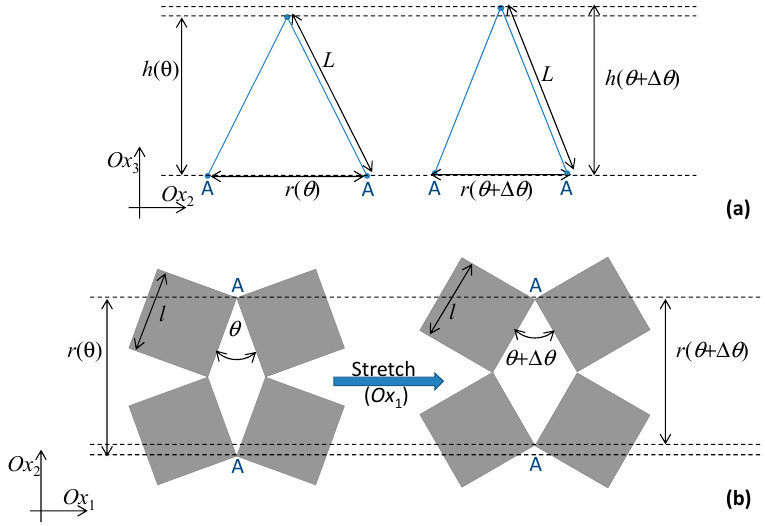
Figure 1. The system being modeled where ( a ) shows the Ox 1 – Ox 2 projections with the unit cell highlighted whilst ( b ) and ( c ) show the Ox 1 – Ox 3 and Ox 2 – Ox 3 projections of the unit cell.